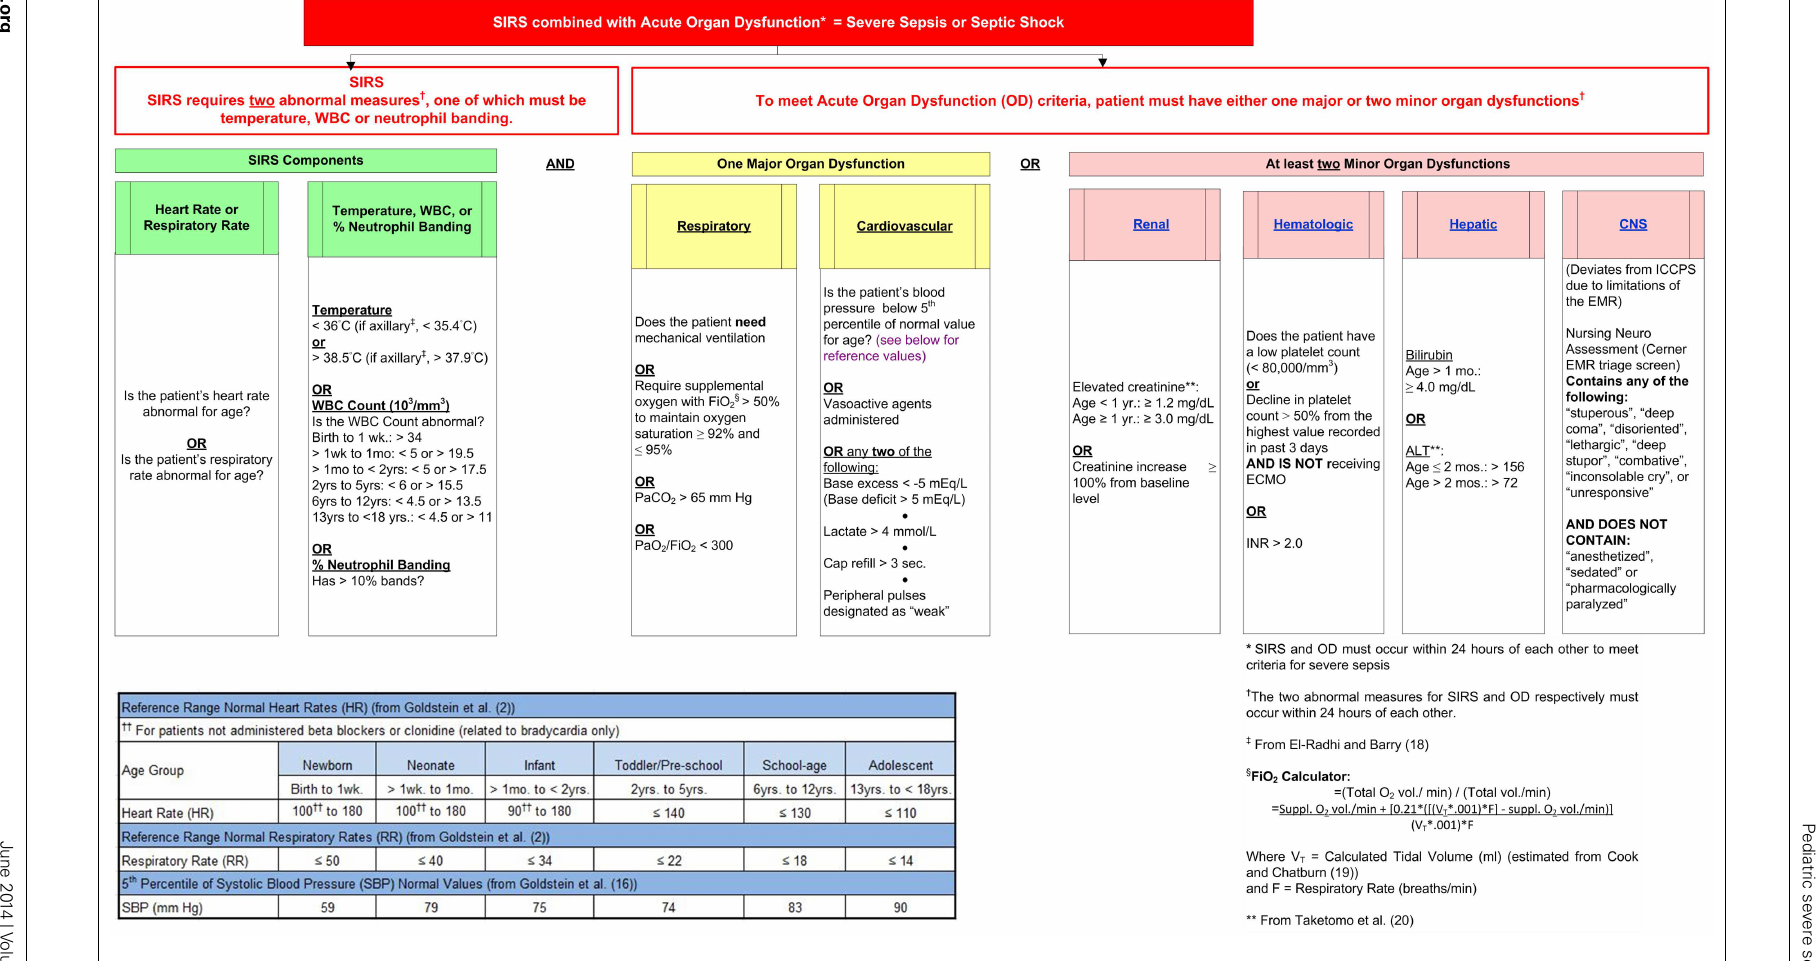
FIGURE 1 | Initial severe sepsis screening tool based on ICCPS (2) criteria